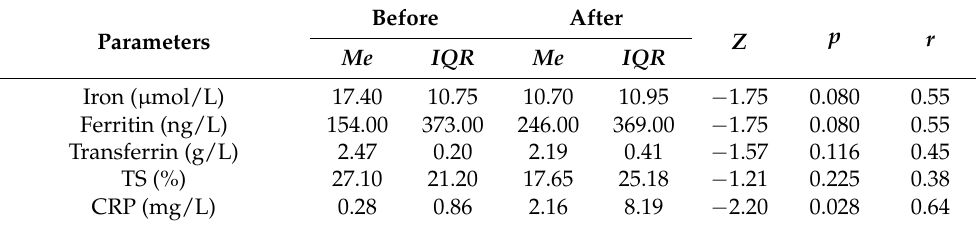
Table 2. Comparison of selected biochemical parameters in the control group (results before and after lesional surgery).